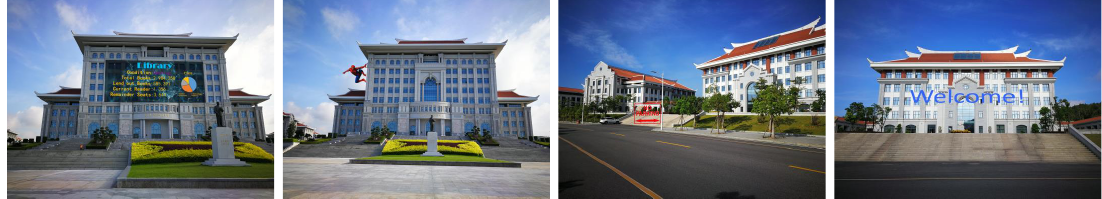
Figure 15. AR applications by the proposed virtual–real registration